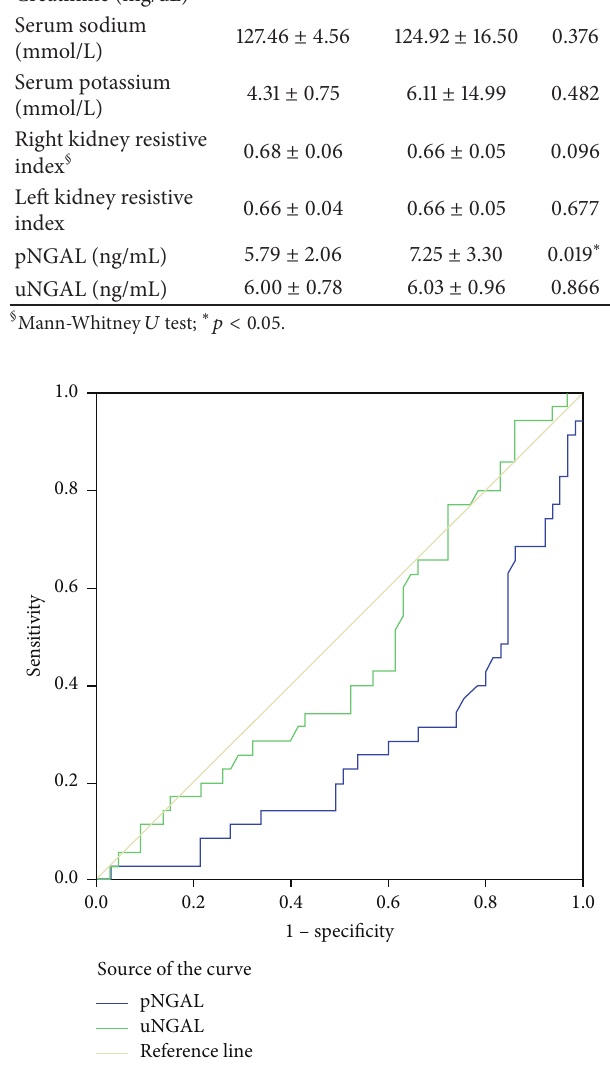
Figure1:Thereceiveroperatingcharacteristic(ROC)curveanalysis of pNGAL ( 𝑝 = 0.001 ) and uNGAL ( 𝑝 > 0.05 ).